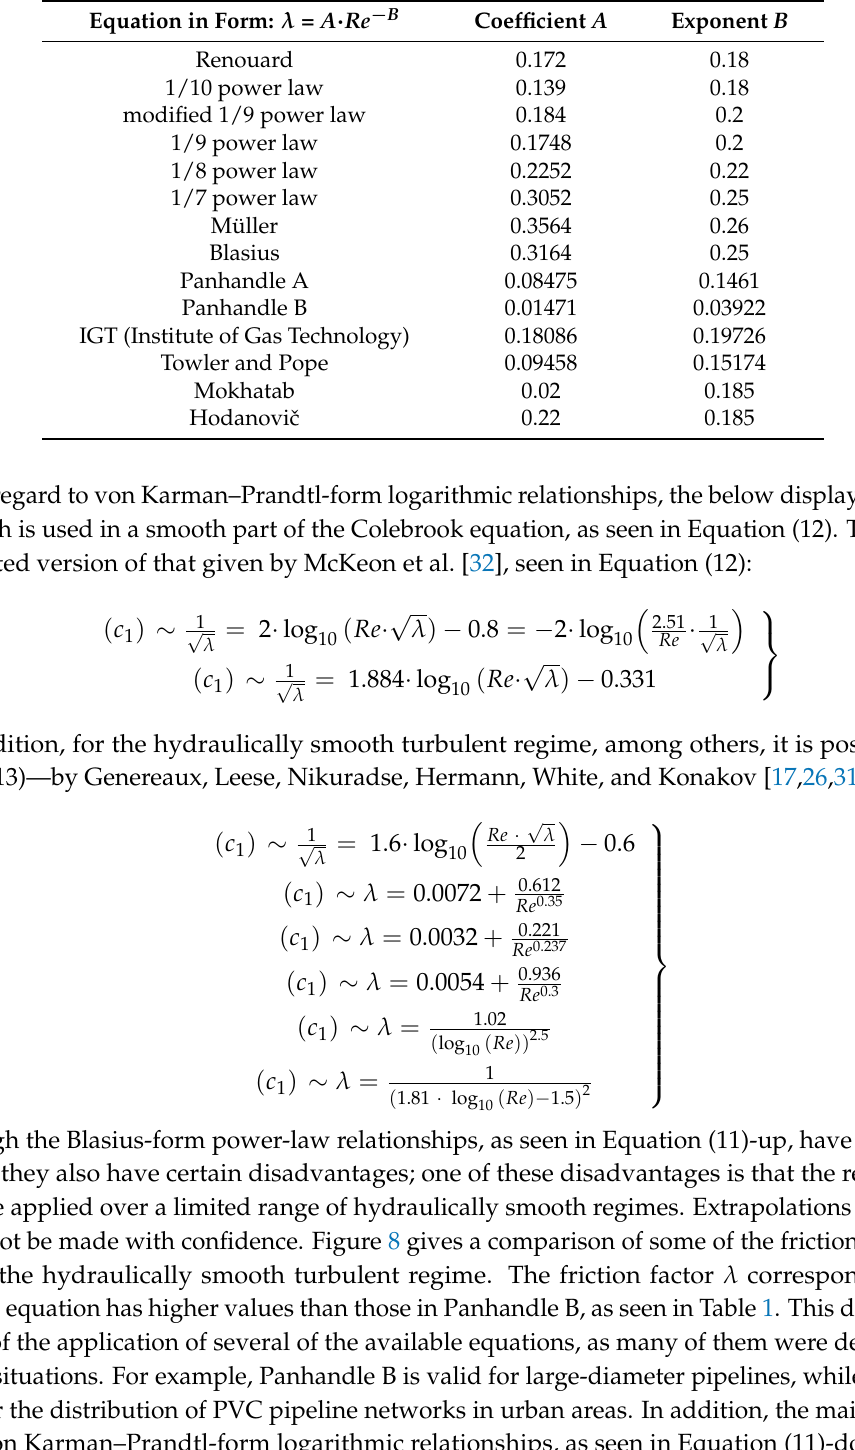
Table 1. Power-law relations for the hydraulically smooth turbulent